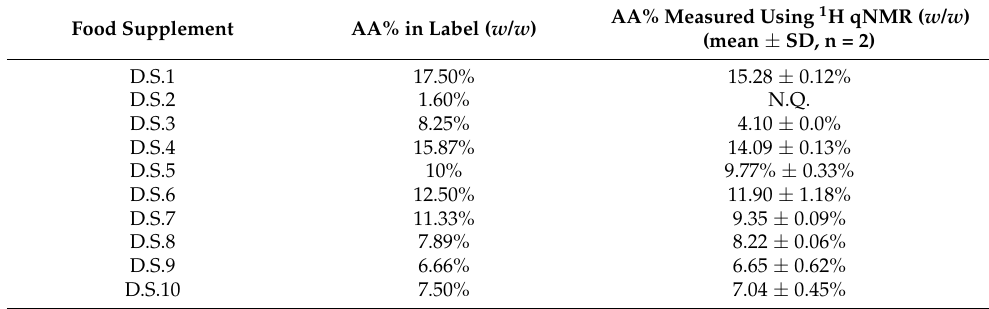
Table 7. Determination of AA in 10 food supplements measured in duplicate by the 1 H qNMR method and comparison with the values declared by manufacturers